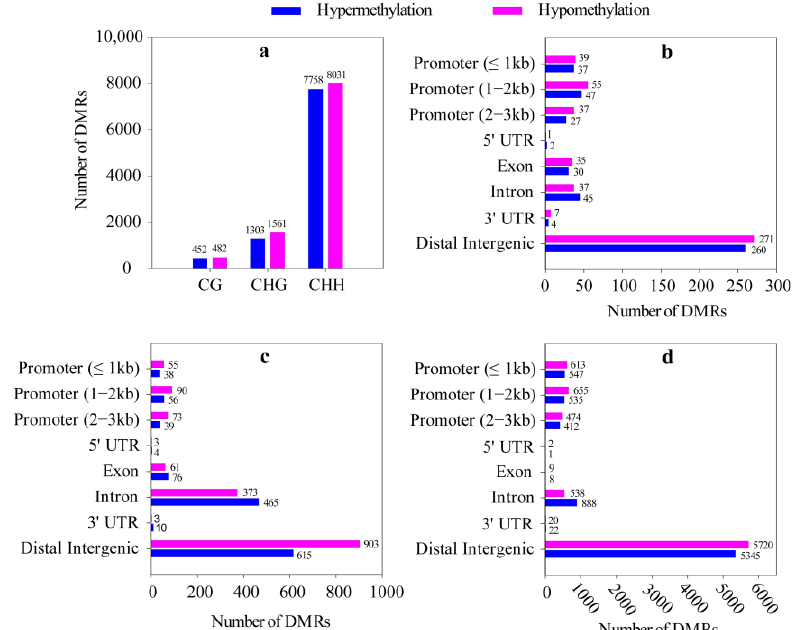
Figure 6. Statistics of differentially methylated regions (DMRs) in SV and PV grafts (SV: grafts with strong growth vigor; PV: grafts with poor growth vigor). ( a ) The number of DMRs in CG, CHG and CHH contexts. The number of DMRs in different gene regions in the CG ( b ), CHG ( c ) and CHH ( d ) contexts (H = A, T, or C). Hypermethylation and hypomethylation in DMRs represent the methylation changes in PV grafts relative to the methylation status in SV grafts. UTR: untranslated region.